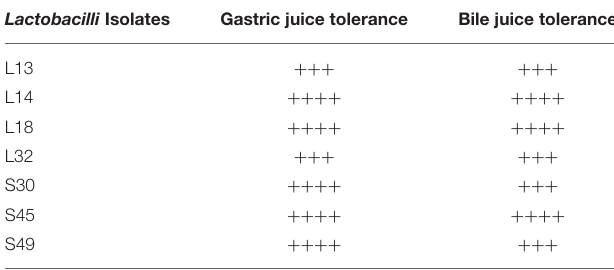
TABLE 4 | Gastric juice and bile juice tolerance of lactobacilli